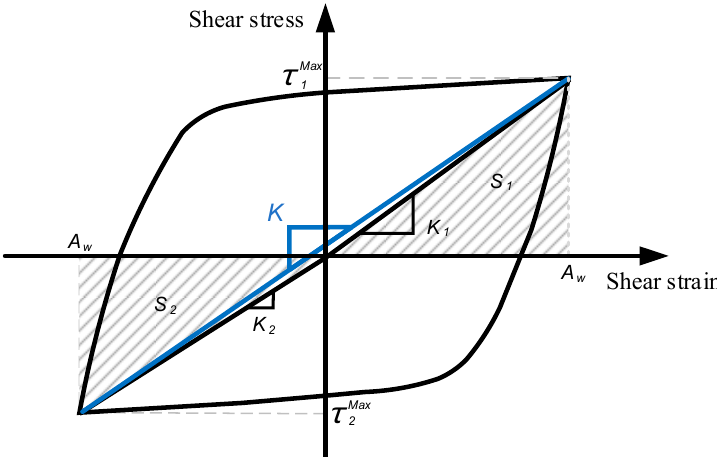
Figure 16. Stiffness and damping ratio.